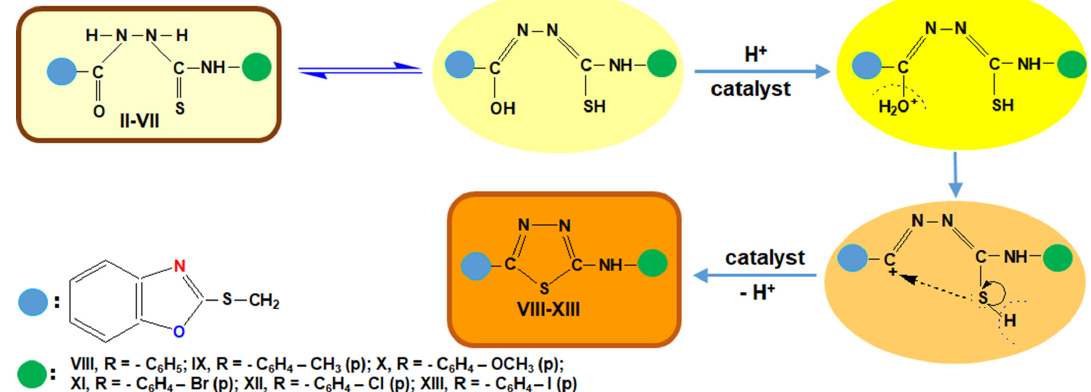
Figure 4. Synthesis of 1,3,4-thiadiazoles (compounds VIII–XIII) and 1,2,4-triazoles (compounds XIV–XIX).